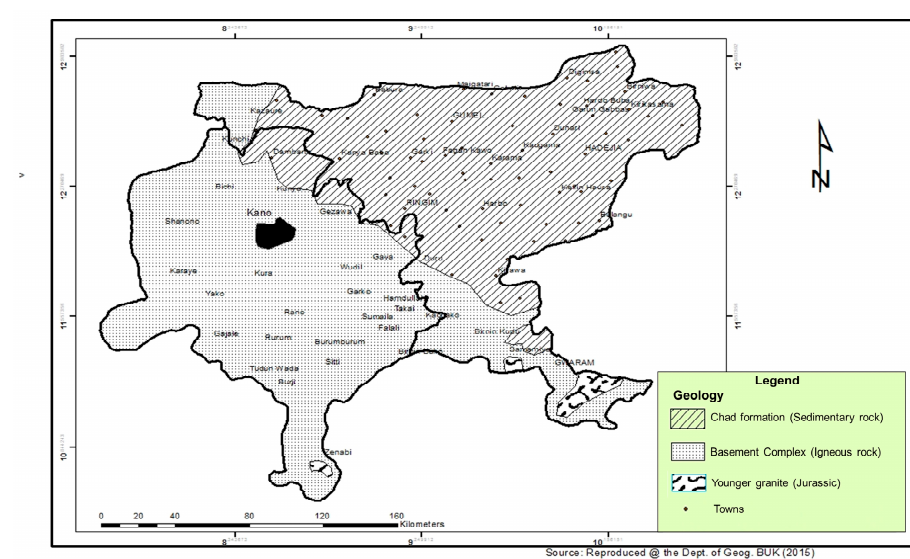
Figure 2. The Geology of Kano Region.